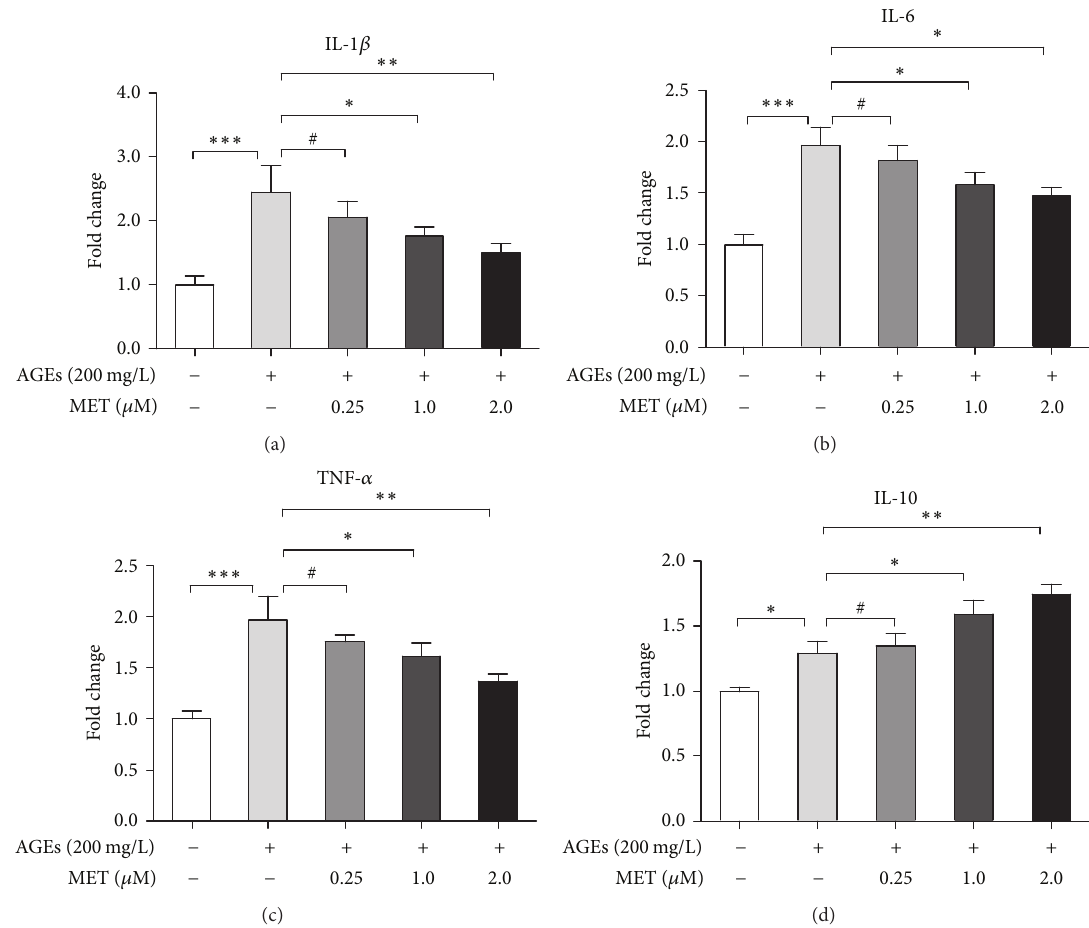
Figure 2: Metformin inhibited AGEs-induced inflammatory response in BMDMs. BMDMs were divided into 5 groups: control, AGEs, AGEs + MET 0.25 (metformin 0.25 𝜇 M), AGEs + MET 1.0 (metformin 1.0 𝜇 M), and AGEs + MET 2.0 (metformin 2.0 𝜇 M). Cells in the last 3 groups were pretreated with different concentrations of metformin (0.25, 1.0, and 2.0 𝜇 M) for 60 min, respectively, and then, together with AGEs group, the 4 groups were stimulated with AGEs (200 mg/L) for 24 h. The control group was treated with BSA (200mg/L) for the same amount of time. RNA then was extracted, and mRNA levels of IL-1 𝛽 (a), IL-6 (b), TNF- 𝛼 (c), and IL-10 (d) were measured by real-time PCR. Bar graphs represent the results (mean ± SD) of three independent experiments. One-way ANOVA was applied and all the overall ANOVA was significant. # 𝑝 > 0.05 ; ∗ 𝑝 < 0.05 ; ∗∗ 𝑝 < 0.01 ; and ∗∗∗ 𝑝 < 0.001 when compared between selected